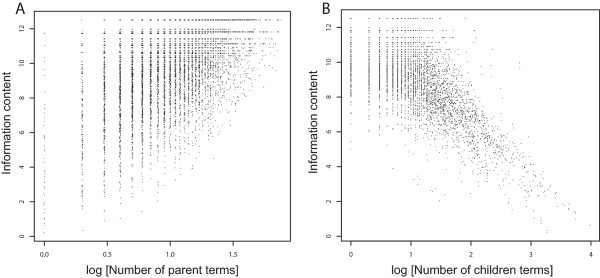
The relationship between the depth of the GO hierarchy and IC. For each GO term, we retrieved the total number of parent terms leading back to the root term, and the total number of children terms. Each dot on the plot represents a GO term, for a total of 8424 terms that have been used in at least one gene annotation within the mouse corpus. The log10 values are plotted each against the pre-calculated IC for that term; jitter was added to each point to reduce overlapping data.